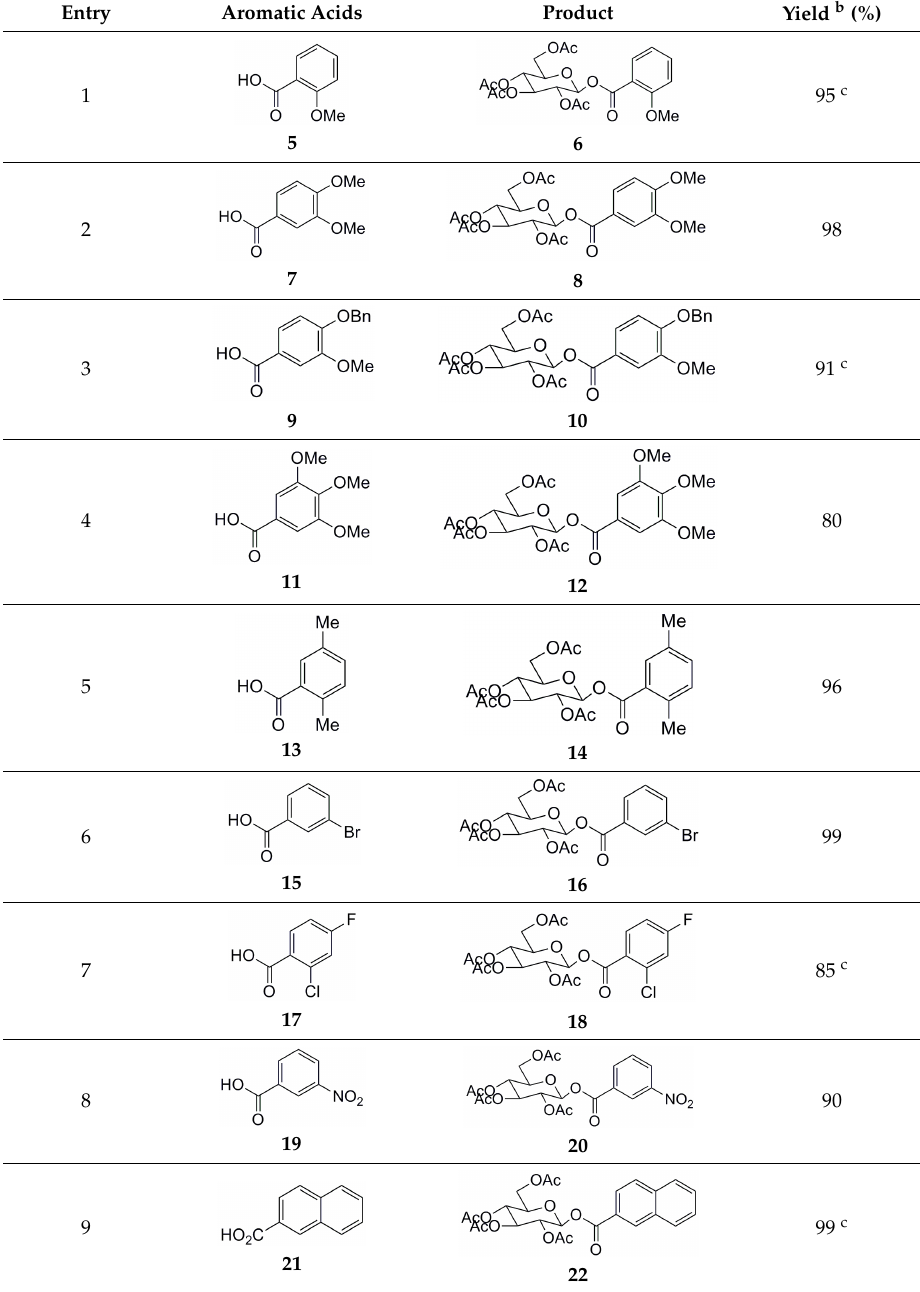
Table 3. The reaction of glucosyl bromide 1 with aromatic acids a .